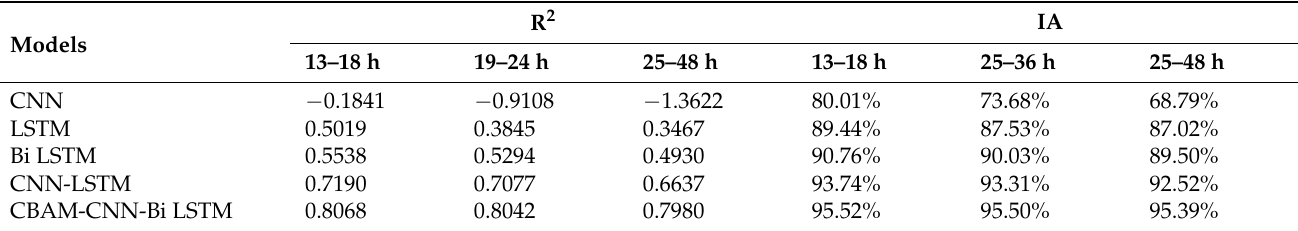
Table 8. Testing accuracy for model prediction